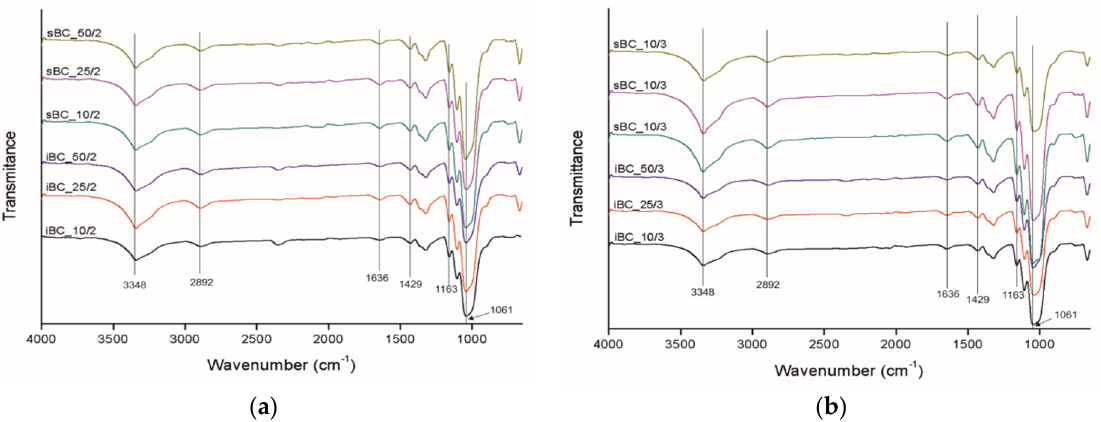
Figure 10. FTIR spectra of GO/BC membranes produced by K. intermedius and K. sucrofermentans with different levels of GO addition with two loadings ( a ) and three loadings ( b ). The spectra range from 4000 cm − 1 to 650 cm − 1